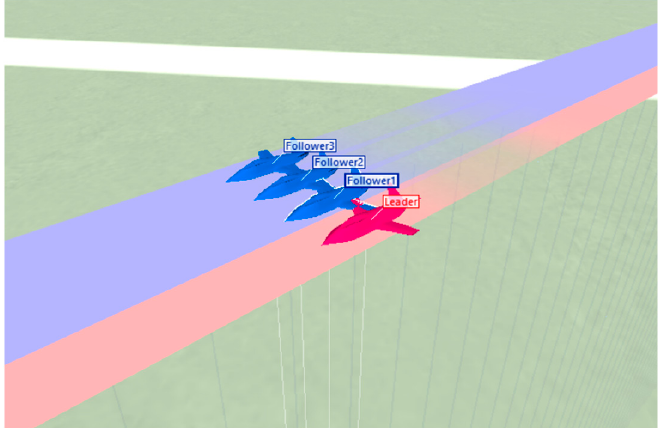
Figure 17. Hardware-in-the-loop simulation. Figure 18. Semi-physical simulation of formation transformation: ( a ) triangular formation; ( b ) inter- mediate state of formation change; ( c ) ladder formation.